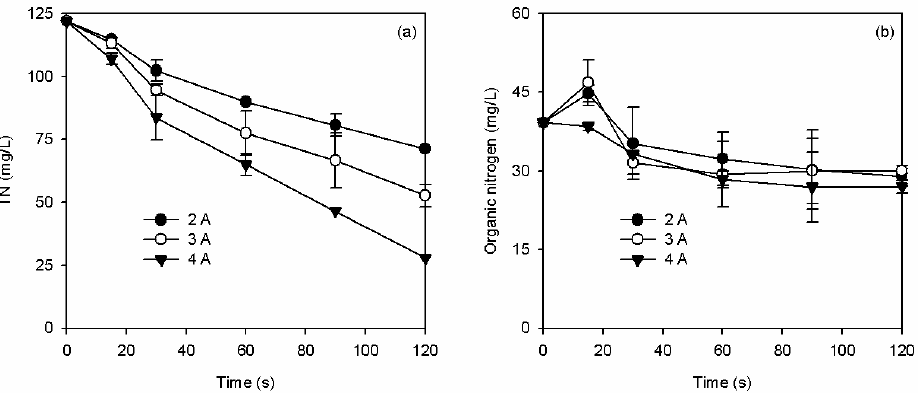
Figure 3. ( a ) Total nitrogen and ( b ) organic nitrogen evolution during the electrochemistry treatment of the spent caustic wastewater with varying currents.